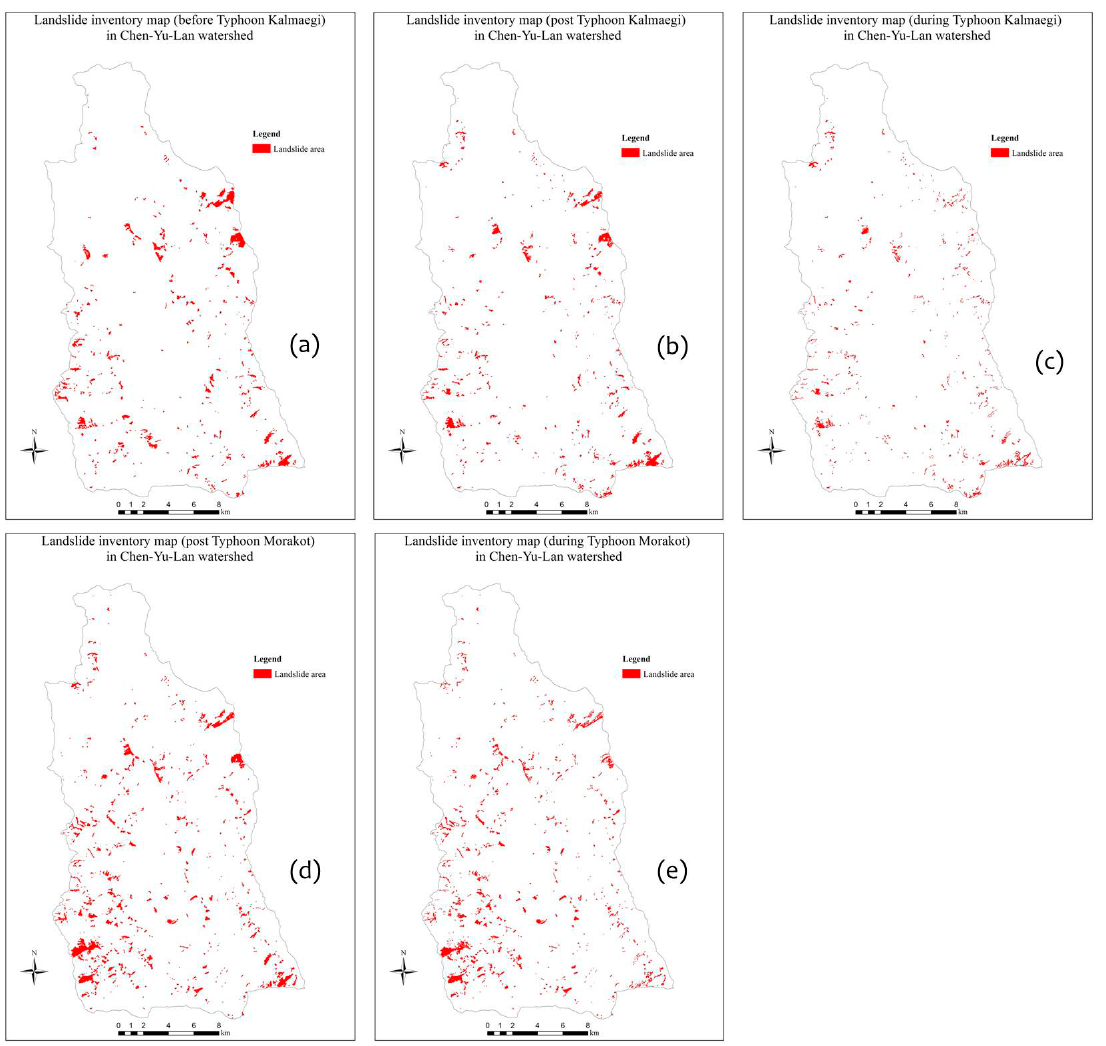
Figure 4. Types of LMs related to typhoons: ( a ) the pre-event Typhoon Kalmaegi LM, ( b ) the post-event Typhoon Kalmaegi LM, and ( c ) the during-event Typhoon Kalmaegi LM, ( d ) the post-event Typhoon Morakot LM, and ( e ) the during-event Typhoon Morakot LM.